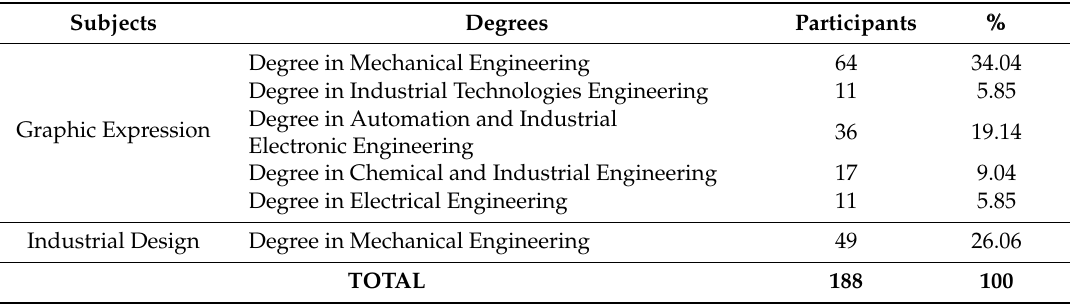
Table 1. Participants by subjects and